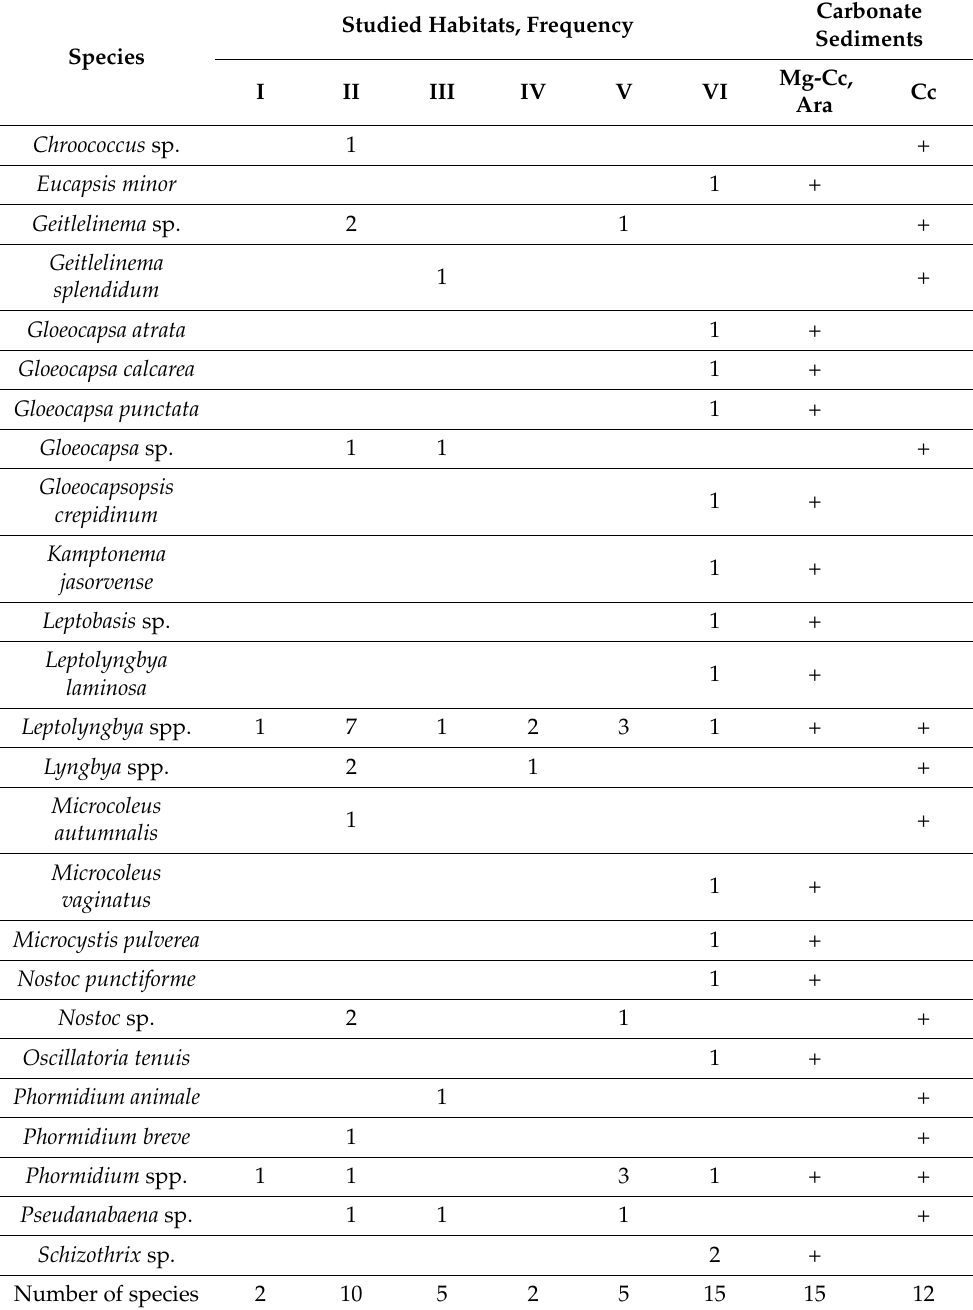
Table 5. The occurrence of cyanobacterial species in sediments from the studied habitats and in carbonate